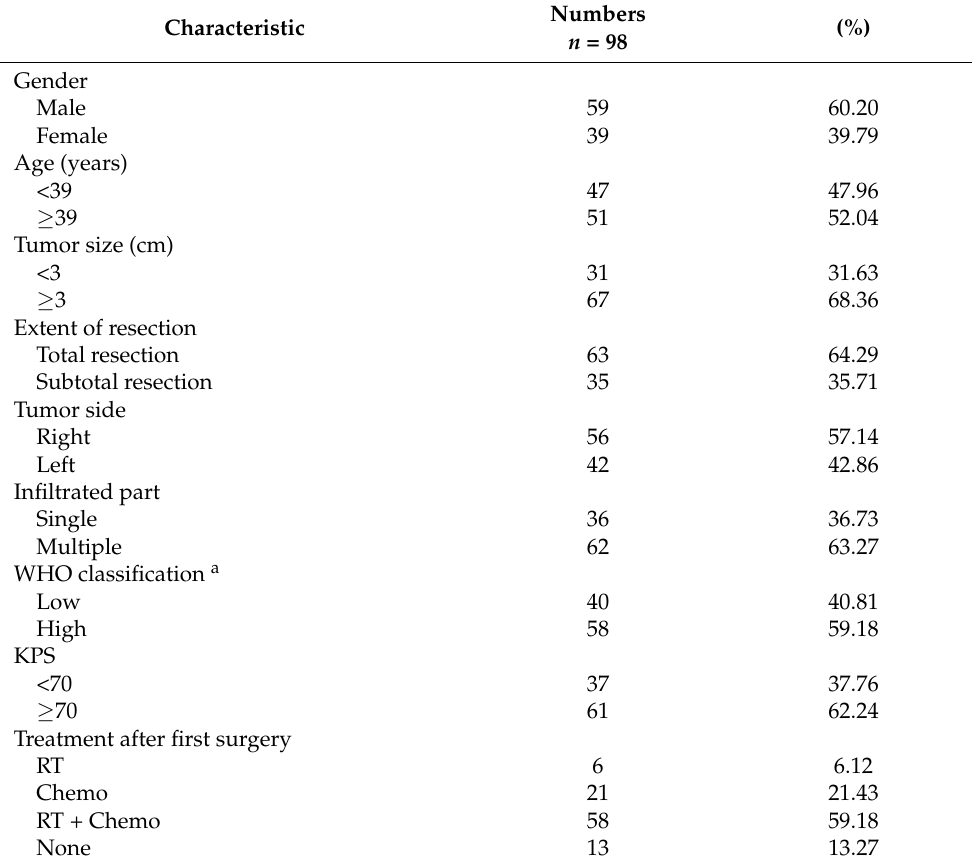
Table 1. Characteristics of patients with